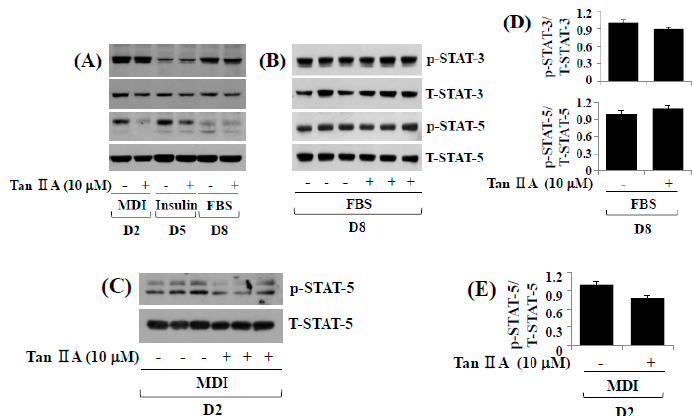
Figure 3. Effects of tanshinone IIA on phosphorylation and expression levels of STAT-3/5 during 3T3-L1 preadipocyte differentiation. ( A ) 3T3-L1 preadipocytes were differentiated with induction medium containing MDI, insulin and FBS in the presence or absence of tanshinone IIA, and harvested at D2, D5, and D8, respectively. Total cellular protein at the indicated time point were extracted and